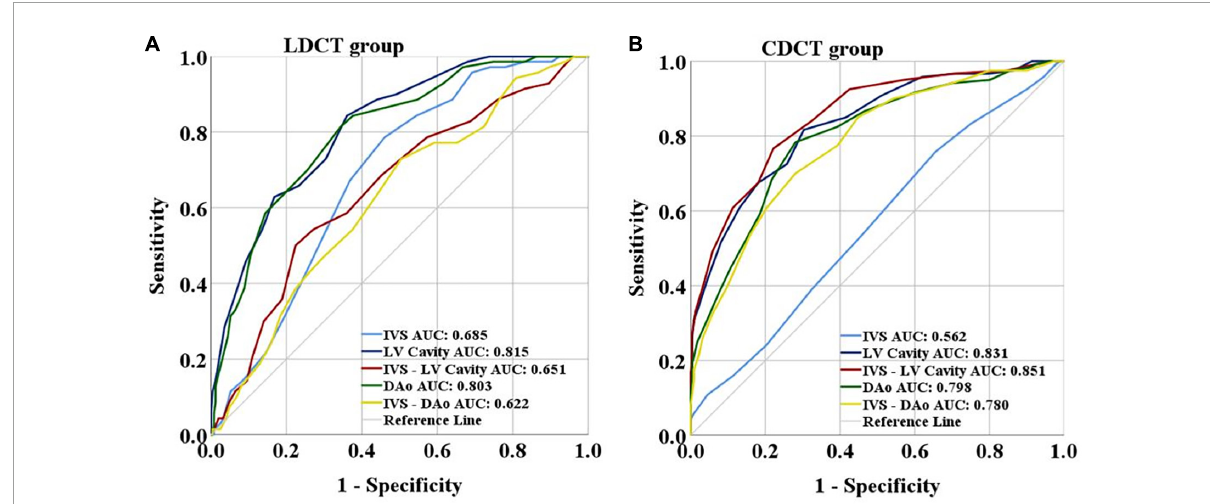
FIGURE4 (A) Results of the ROC curve of LDCT group. (B) Results of the ROC curve of CDCT group. LDCT, low dose computed tomography; CDCT, conventional dose computed tomography; IVS, interventricular septum; LV, left ventricular cavity; IVS-LV, CT attenuation difference between LV and IVS; DAo, descending aorta; IVS-DAo, CT attenuation difference between DAo and IVS; ROC, receiver operating characteristic; AUC, area under the